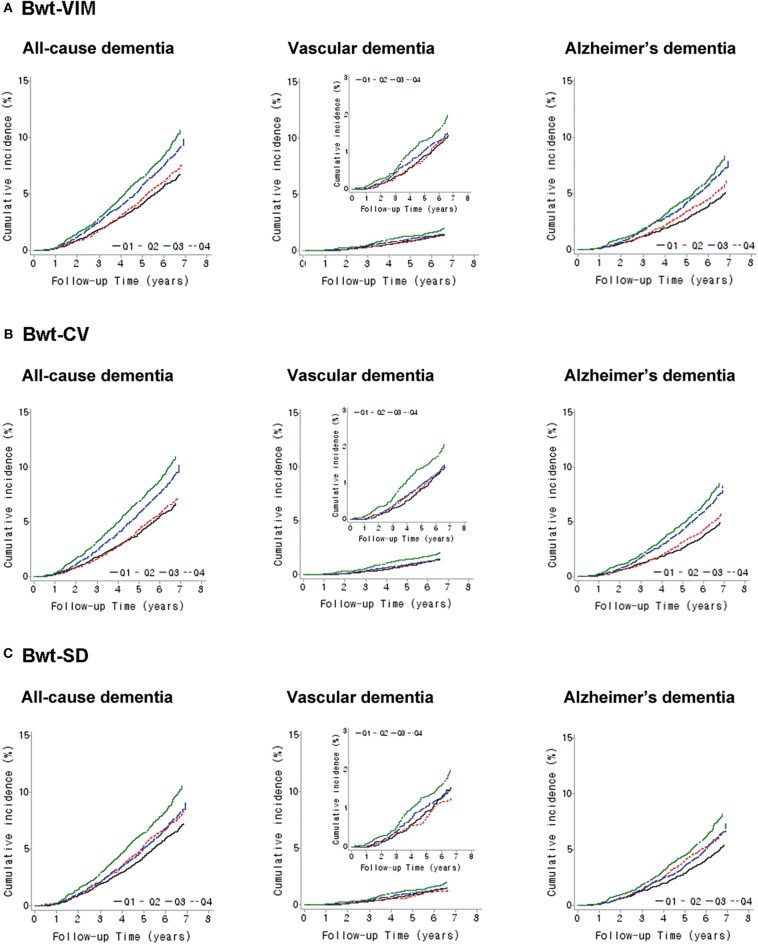
Kaplan–Meier estimates of cumulative incidence of dementia according to quartiles of body weight (Bwt) variability (A) Bwt-VIM, (B) Bwt-CV, (C) Bwt-SD. CV, coefficients of variance; SD, standard deviation; VIM, variability independent of the mean.